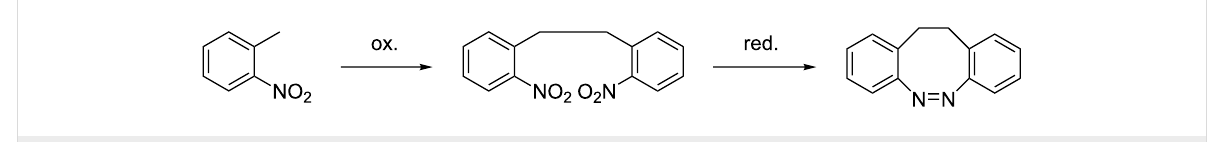
Scheme 1: Key reactions in diazocine synthesis.